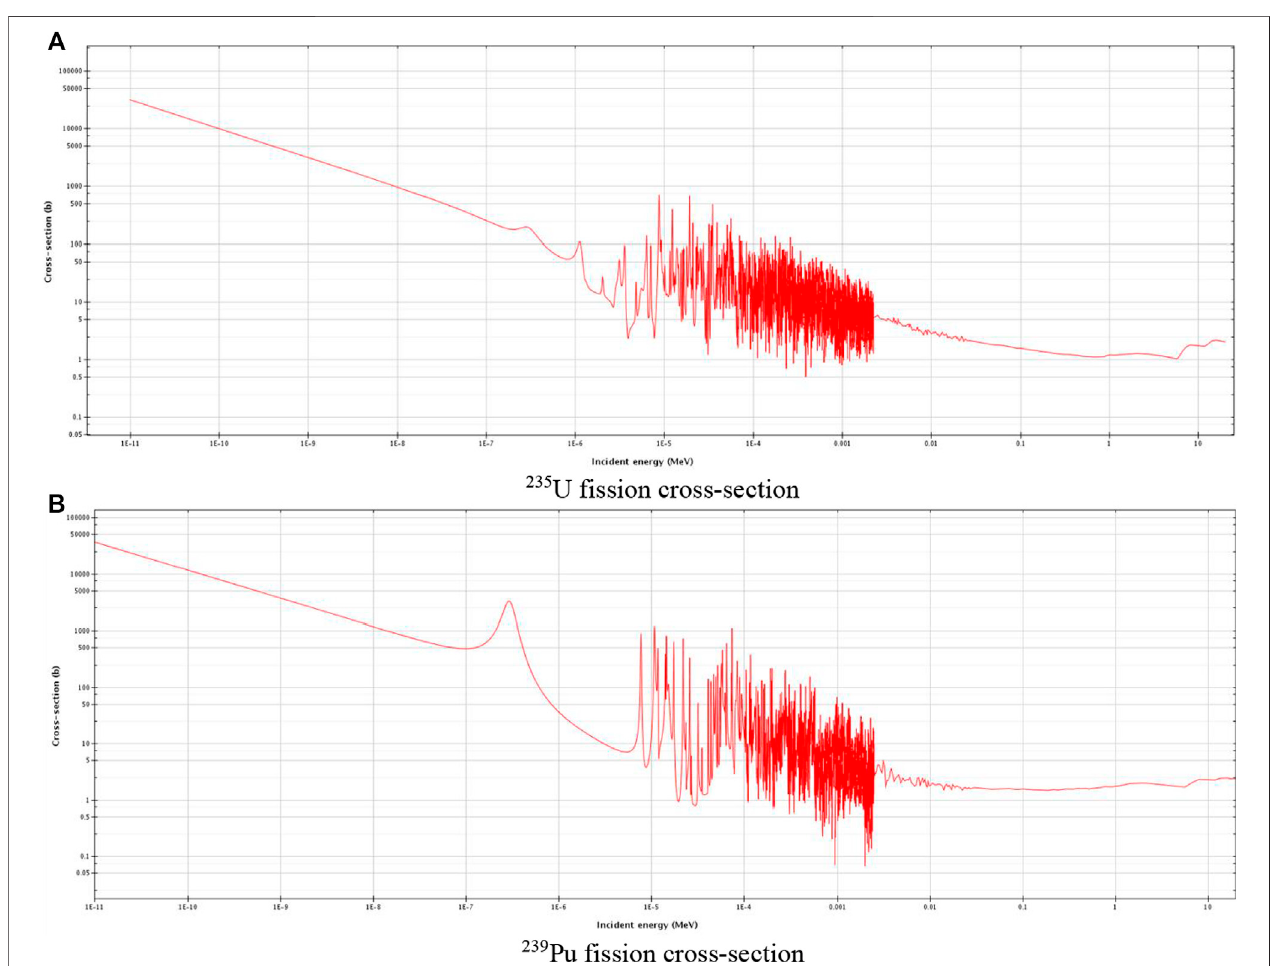
FIGURE 7 | Diagram of the fi ssion cross-sections for typical fuel nuclides. (A) 235 U fi ssion cross-section. (B) 239 Pu fi ssion cross-section.